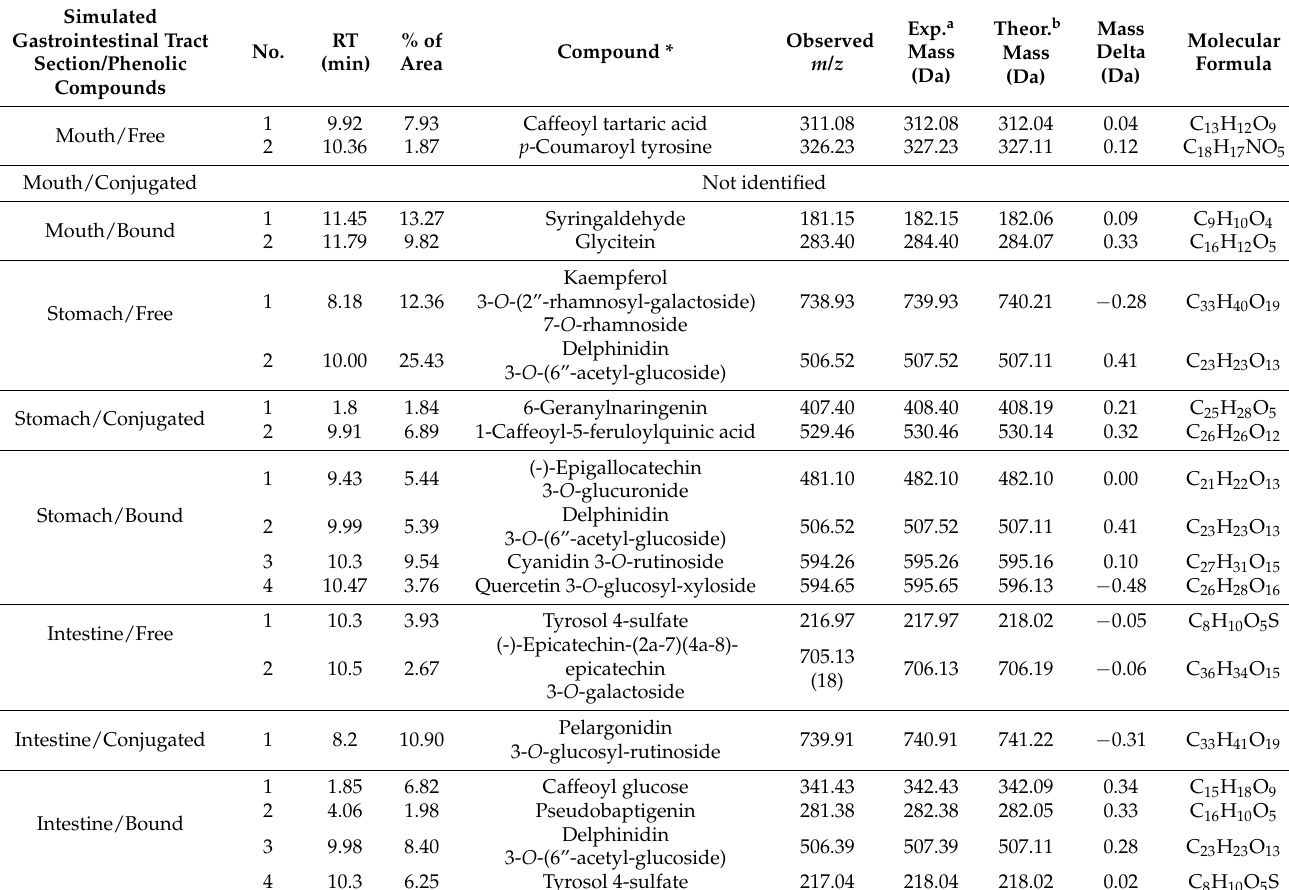
Table 6. Phenolic compounds identified by UPLC-MS during in vitro